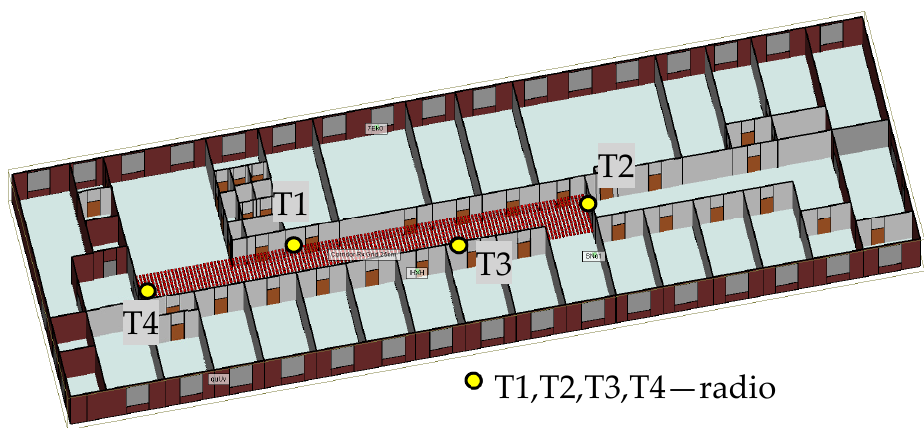
Figure 4. Building fragment model generated in Remcom Wireless InSite software.